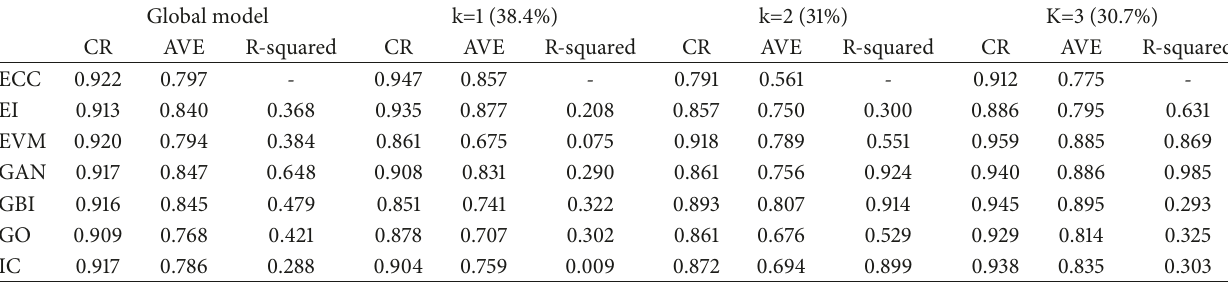
Table 9: Reliability measurements for the general model and for the three segments.